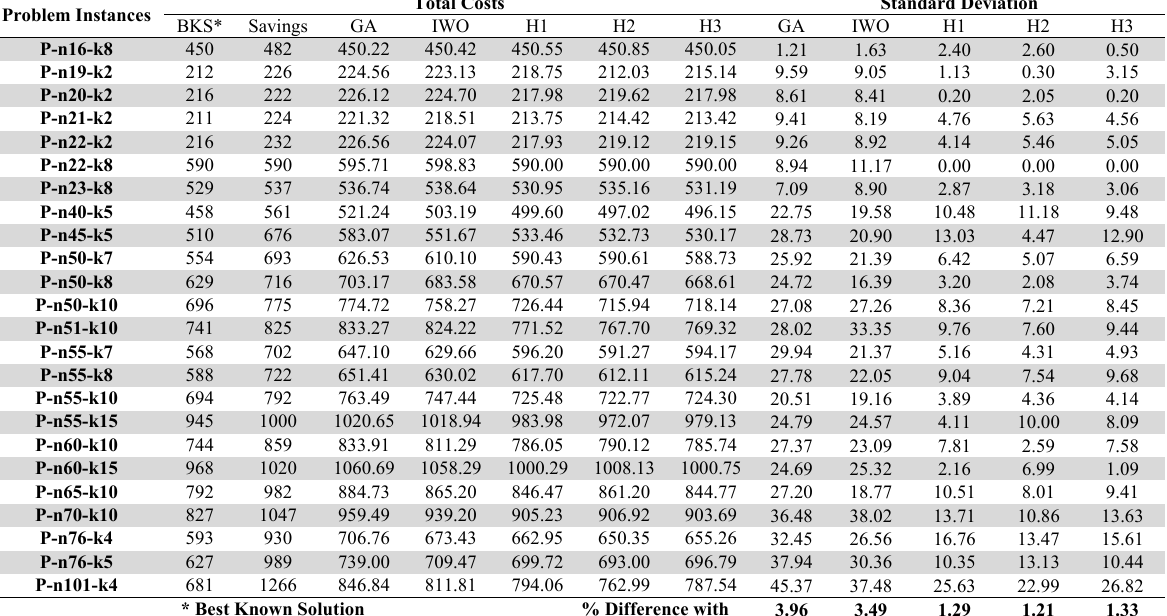
Table 1 Comparison of the methods for P group test instances Problem